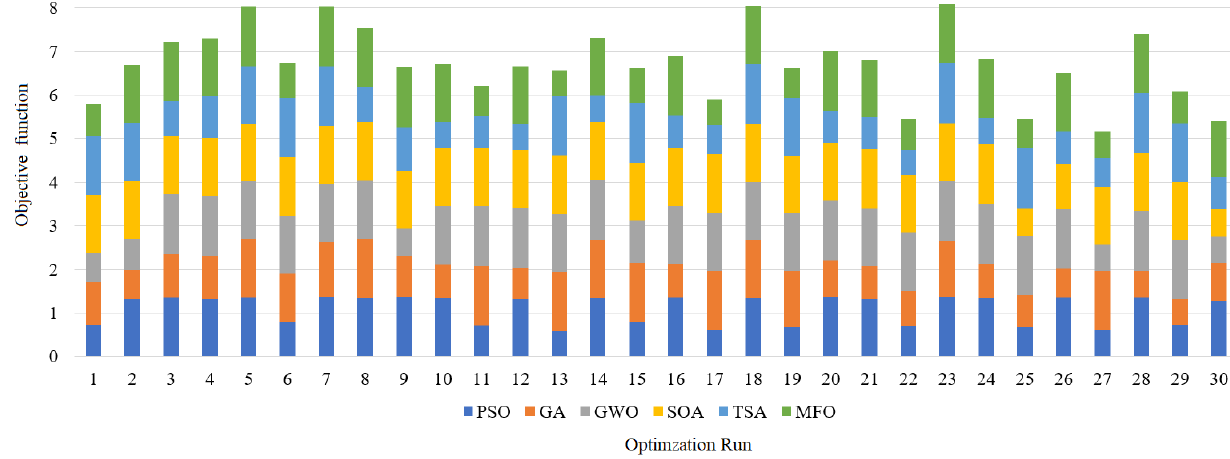
Figure 7. Details of 30 runs applying the studied algorithms. Table 2. Details of 30 runs applying studied algorithms.